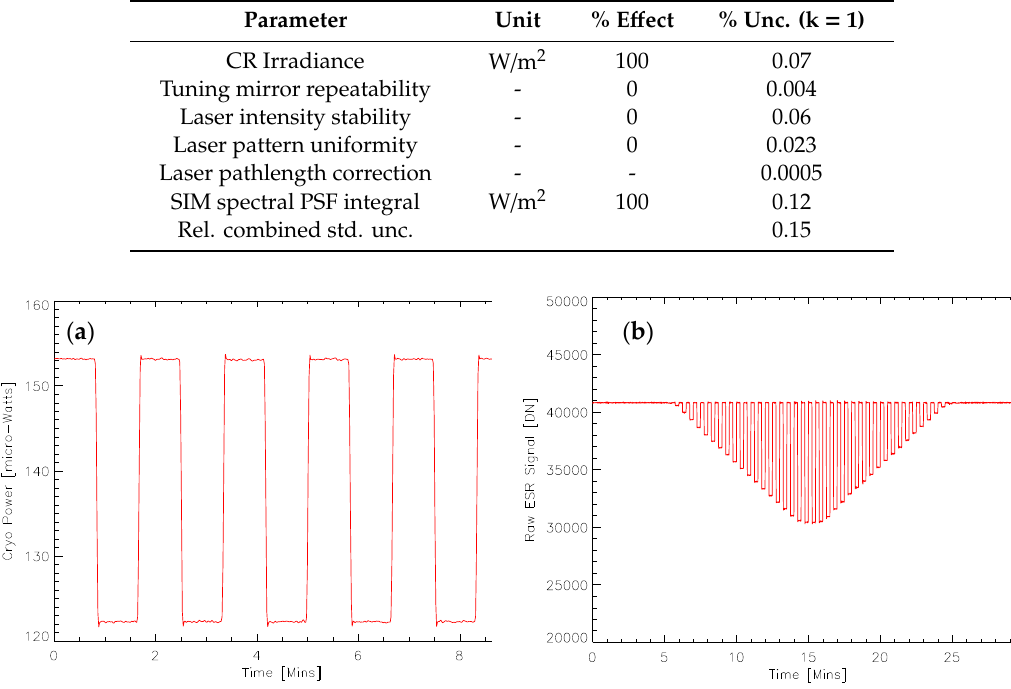
Figure 12. ( a ) SRF CR power measurement (through overfilled calibrated aperture) for stabilized 532 nm laser showing ~30 µW of power. This power is chosen to closely match the solar power level detected by SIM at 532 nm so as to closely match the true dynamic rage of the SSI measurement. ( b ) Immediately after CR power measurement, the stabilized laser, if directed (via turning mirror in Figure 2) into the SIM (overfilling entrance slit), and the prism are scanned across the full spectral passband to generate the spectral instrument response at 532 nm. For these measurements, the shutter opens and closes for each prism angle position to acquire a light and dark measured signal, respectively.